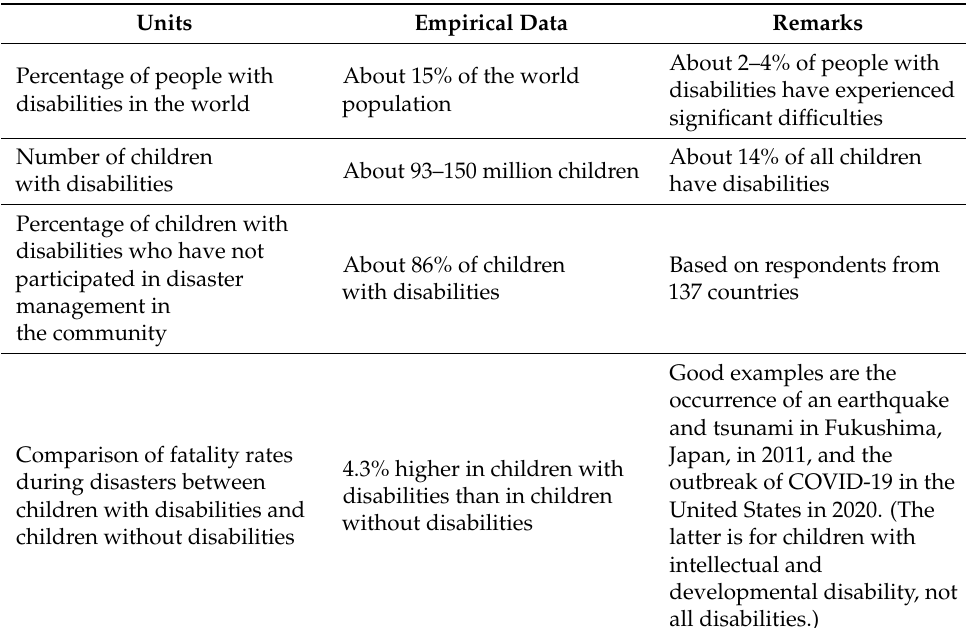
Table 1. Supplementary information on children with disabilities